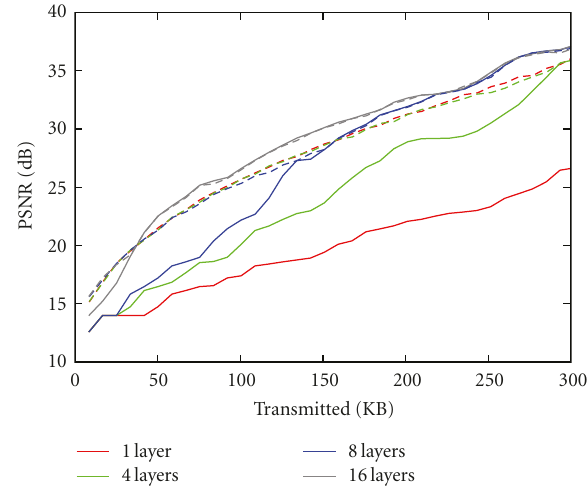
Figure 5: Performance evaluation of BWLT in an interactive image transmission scenario (dashed plot), compared to the common approach of layer truncation (solid plot). Results for an aerial